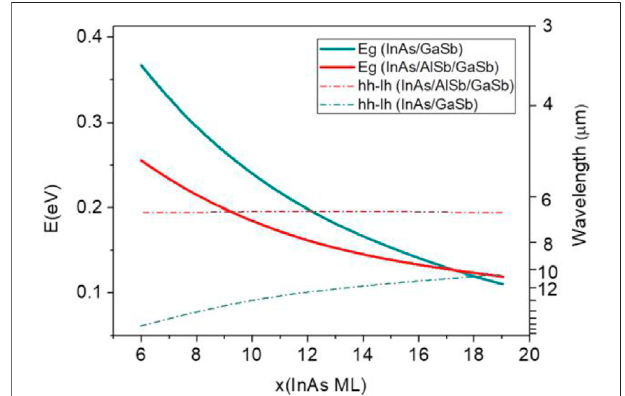
FIGURE9| E g andhh – lhsplitting energiesplottedasfunctionsofx(InAs ML) for the (InAs) x /(GaSb) 9 and (InAs) x /(AlSb) 3 /(GaSb) 6 T2SL structures with x varying from 6 to 19 ML. when InAs thickness is 17 ML, E g values intersect at 124 meV with a corresponding wavelength of 10 μ m within the long- wavelength range. Bandgap energy decreases below the hh-lh splitting energy as InAs ML